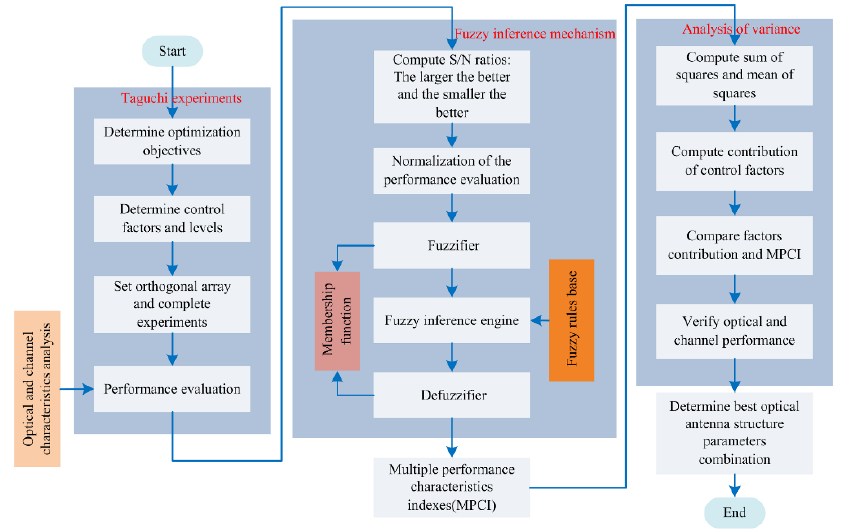
Figure 8. Schematic diagram of the flowchart for the Taguchi and fuzzy logic methods.